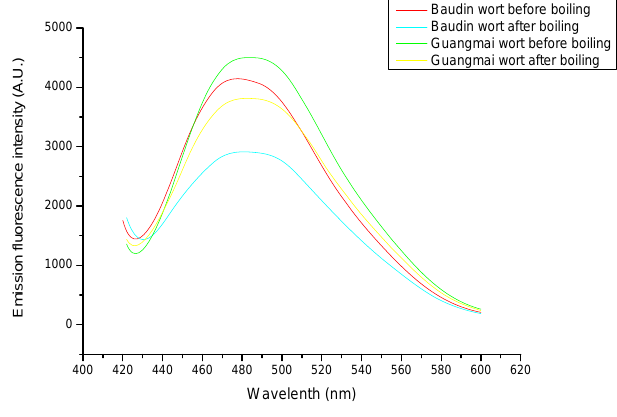
Figure 1 . Emission fluorescence intensity spectra of wort proteins before and after boiling with the two varieties (using ANS as a fluorescence probe).